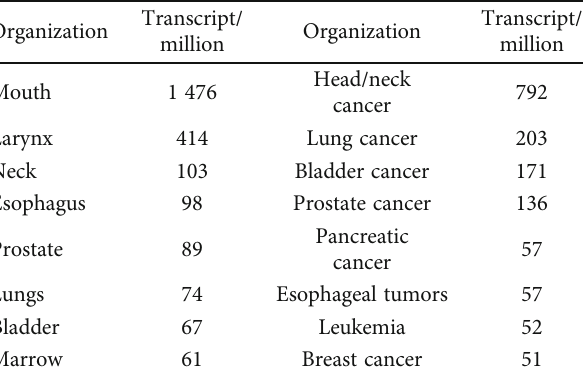
Figure 4: The transcriptional level of hub genes was veri fi ed by Oncomine database. Oncomine database results show that BIRC5, CDC20, NDC80, CENPF, MAD2L1, CDCA8, and KIF2C and levels of BUB1, FAM83A, and BUB1B were signi fi cantly upregulated in breast cancer tissues. Table 1: FAM83A gene electron